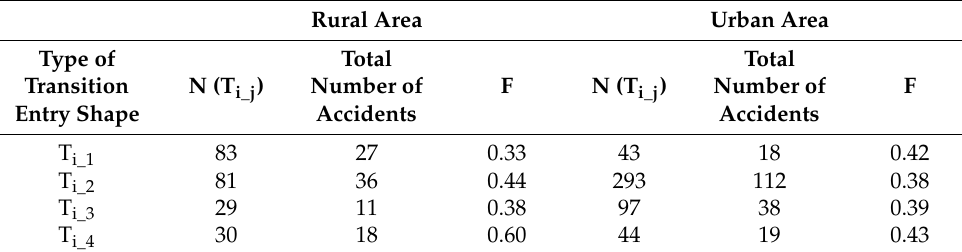
Table 5. Analysis related to the transition exit shape for rural and urban areas.